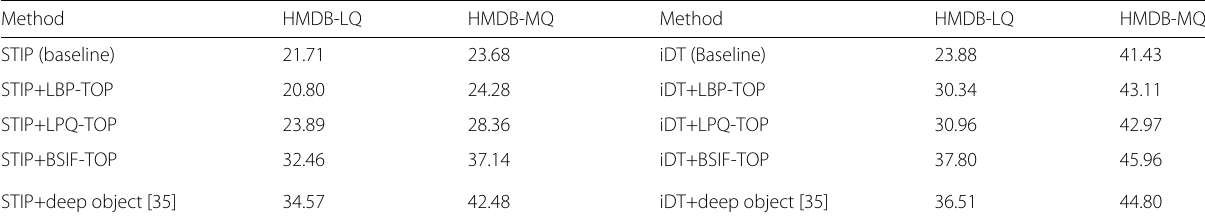
Table 4 Recognition accuracy (%) of various feature combinations on HMDB-LQ and HMDB-MQ subsets